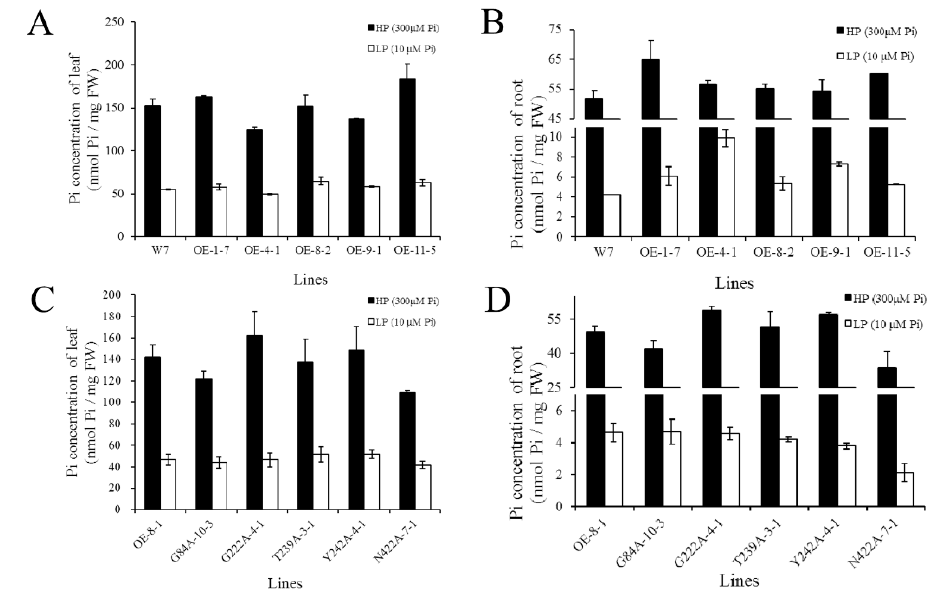
Figure 8. The Pi concentration of CmPT2 -OE T2 lines under different phosphorus conditions. ( A , C ): Pi concentration of leaf; ( B , D ): Pi concentration of root; A, B: Pi concentration of W7 and CmPT2 -OE lines; ( C , D ): Pi concentration of CmPT2 -OE-8-1 and Cmphts -OE lines.